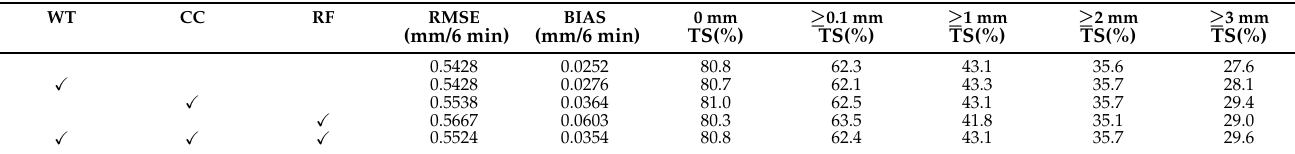
Table 9. Ablation studies on different components. UNet baseline, baseline with WT, baseline with CC, baseline with RF and RRED-Net from up to down, respectively.